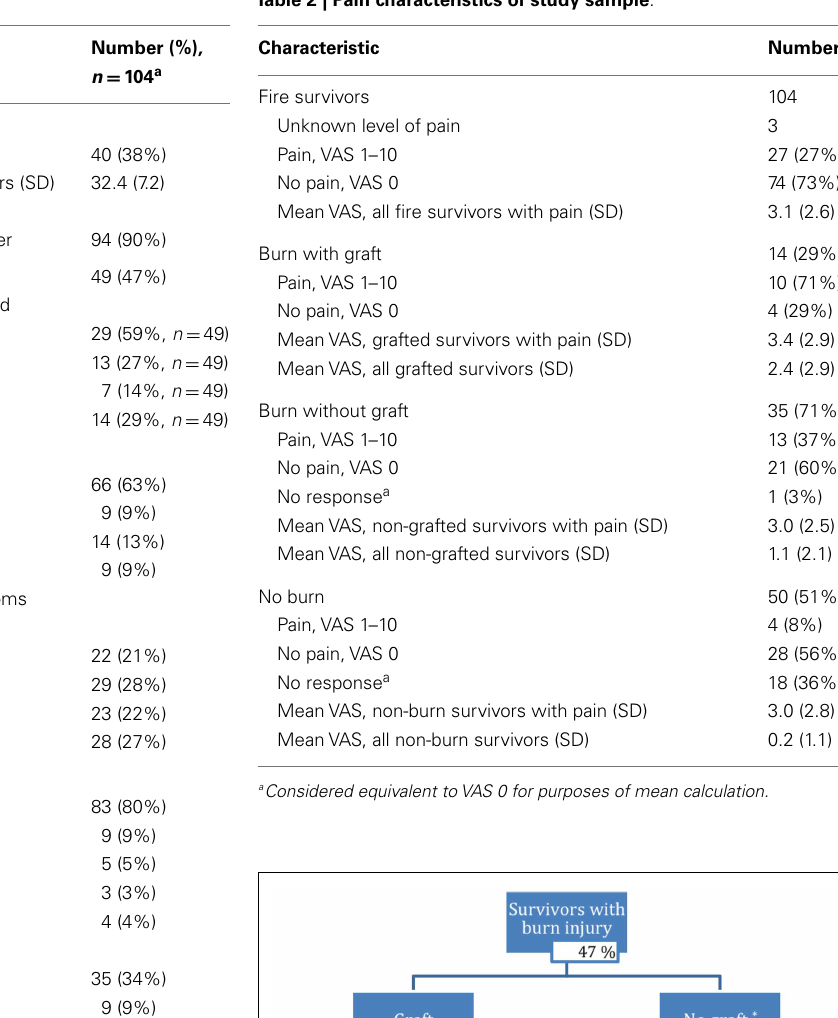
Table 1 | Characteristics of study sample . Table 2 | Pain characteristics of study sample .